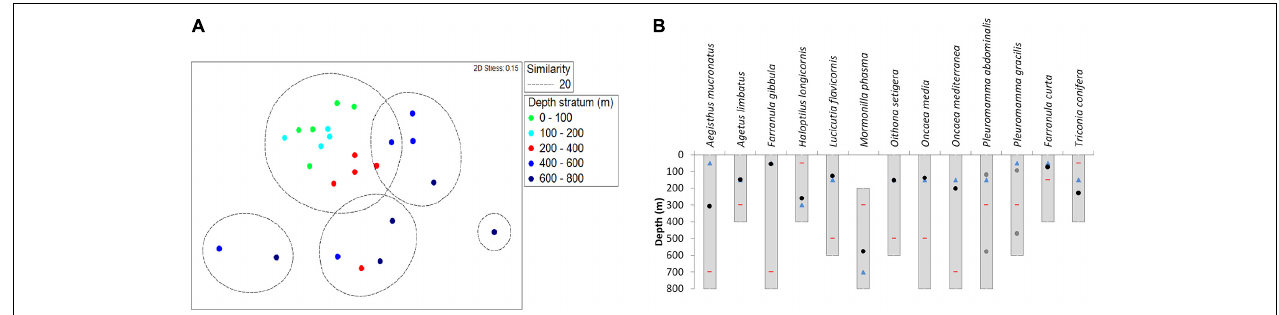
FIGURE 7 | Multivariate analysis of the composition and abundance of copepods species in the SPSG ( ∼ 27 ◦ S) during October–November 2015. (A) Non-metric multidimensional scaling (nMDS) plot on the first two axes based on the Bray-Curtis similarities of the log (x+1) of transformed copepod species abundance data for depth strata. (B) The weighed vertical distribution ( WMD) for species selected by SIMPER analysis (black dot), depth stratum with the lowest abundance (red stripe), depth for the highest abundance (blue triangle), and WMD for species with bimodal distribution (gray dot).